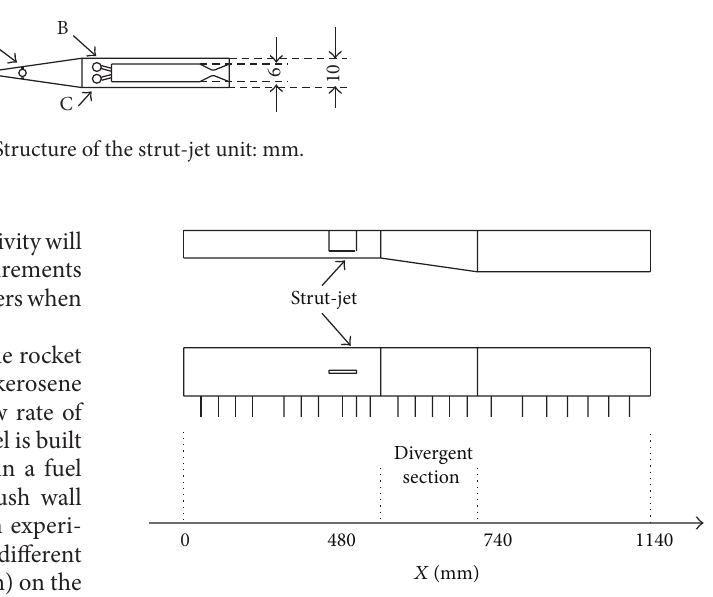
Figure 2: Structure of the strut-jet RBCC combustor model unit: